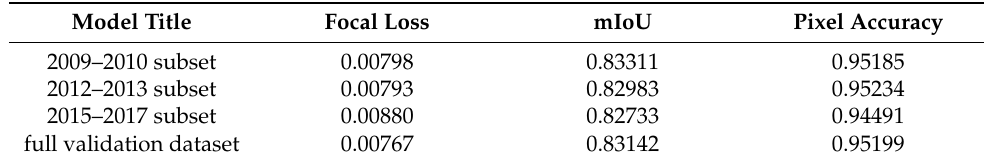
Table 4. Focal loss, mIoU, and pixel accuracy values for the fine ‐ tune validation subsets of different periods for the M123 model after the training.